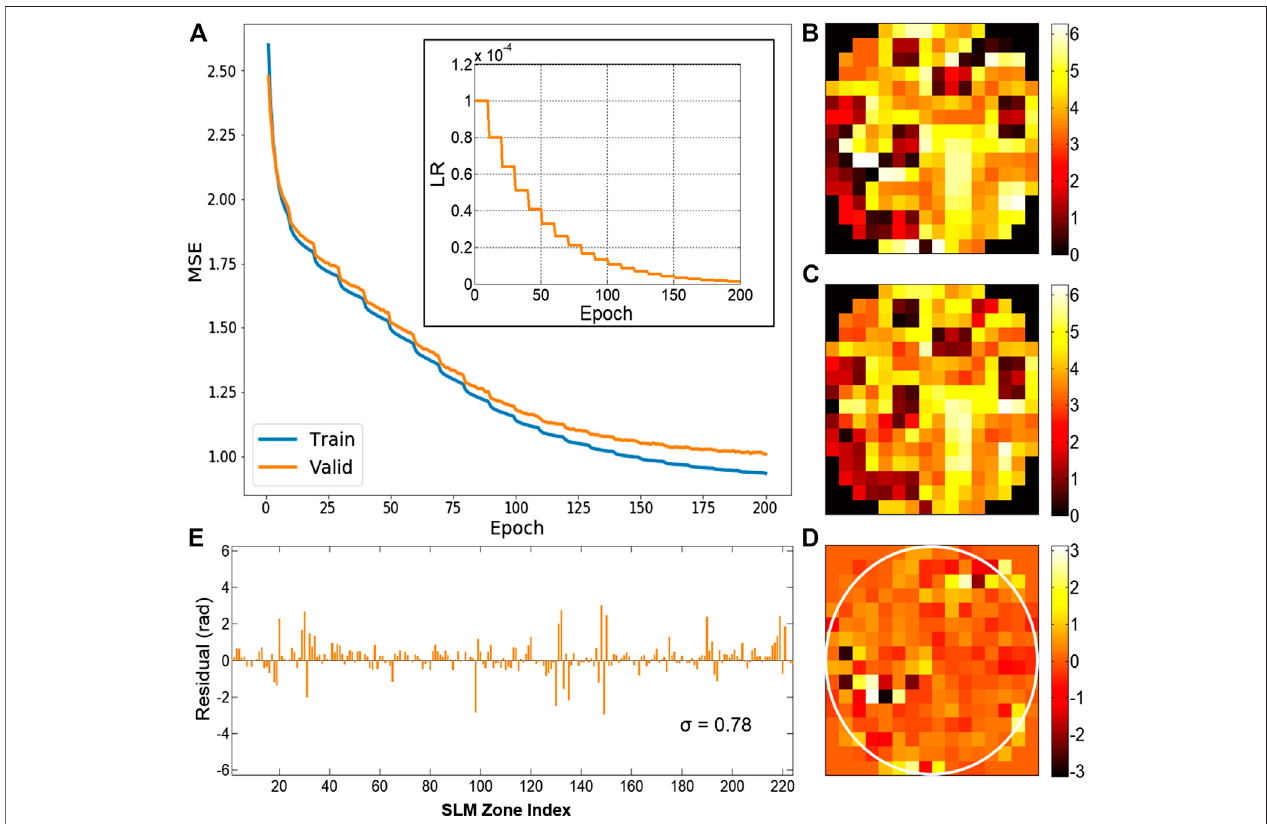
FIGURE2|(A) ThedescentcurveofMSEduringthetrainingprocess.Sub fi gure:theLRdecaycurve. (B) Theidealcorrectionphasepattern. (C) Thephasepattern predicted by the trained network. (D) The phase difference pattern between ( B ) and ( C ). (E) The bar chart of the phase difference on every SLM zone from ( D ), with the standard deviation σ being